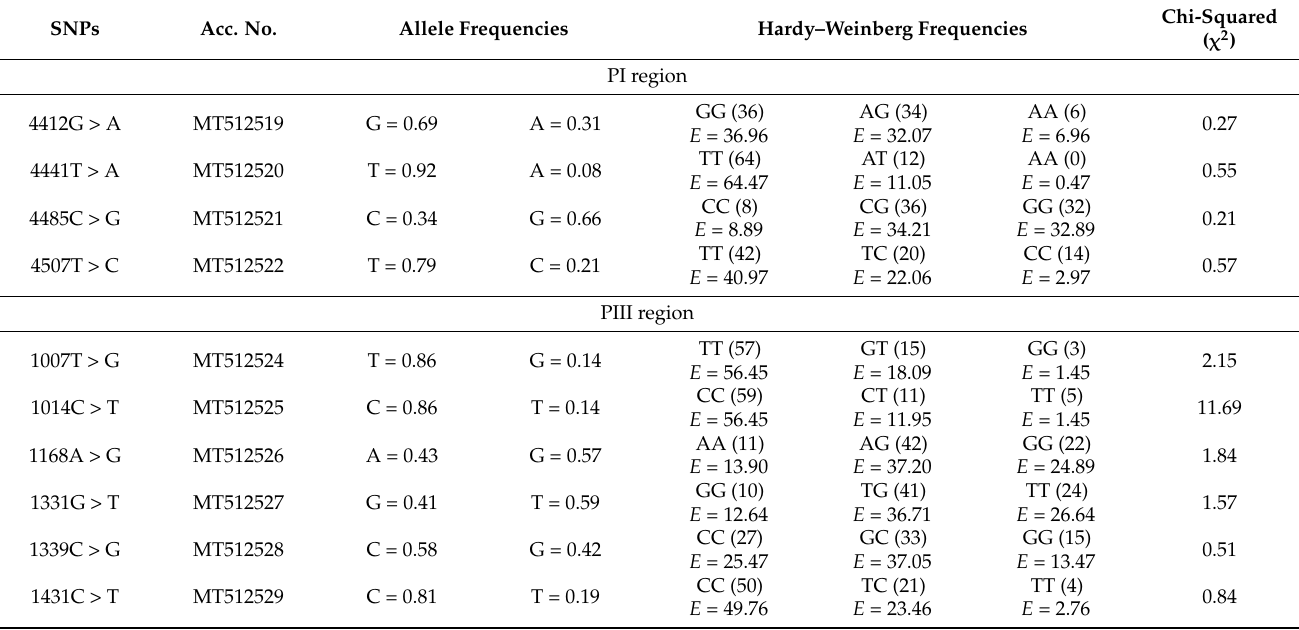
Table 3. Genotype and allele frequencies in single-nucleotide polymorphisms (SNPs) at promoter I and promoter III of the ACAC α gene in Najdi sheep.